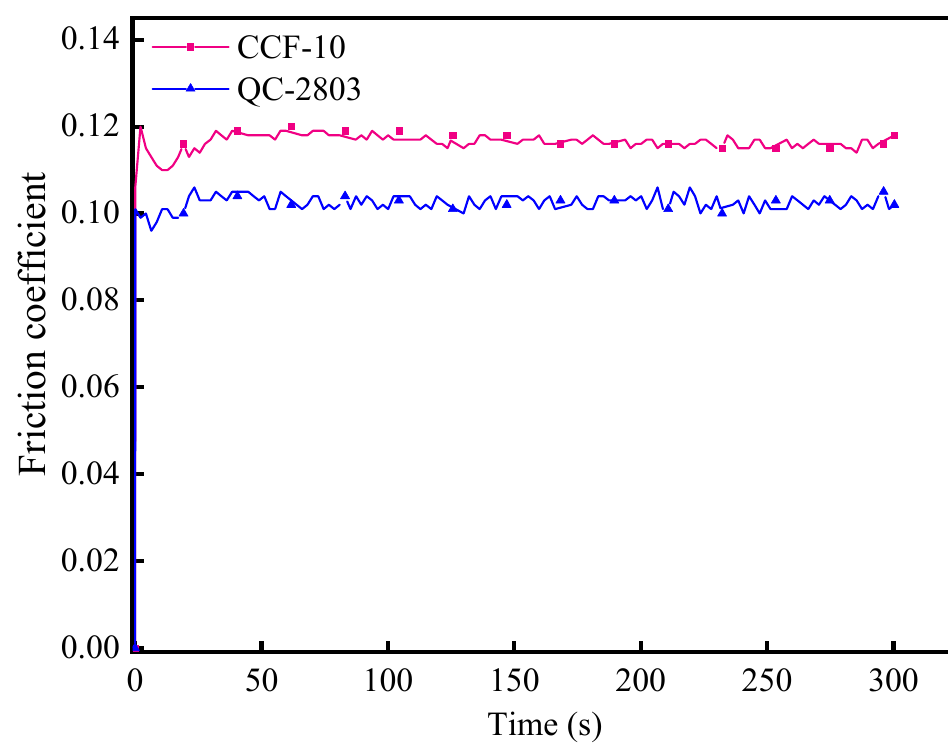
Figure 4. Cooling curve of CCF-10 and QC-2803.